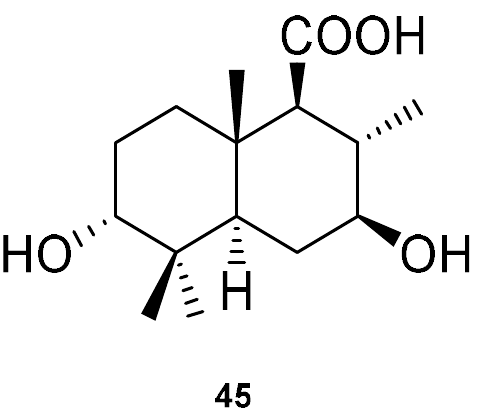
Figure 11. Cytotoxic drimanes from Aspergillus flavus against HeLa, MCF-7, MGC-803, and A549 cells [58]. W. Feng et al. used Fomes officinalis as a source of drimane sesquiterpenoids (Figure 12) [59]. Only drimane 45 exhibited a moderate cytotoxic activity against HL-60 leukemia, Bel-7402 hepatoma, and KB nasopharyngeal cells.